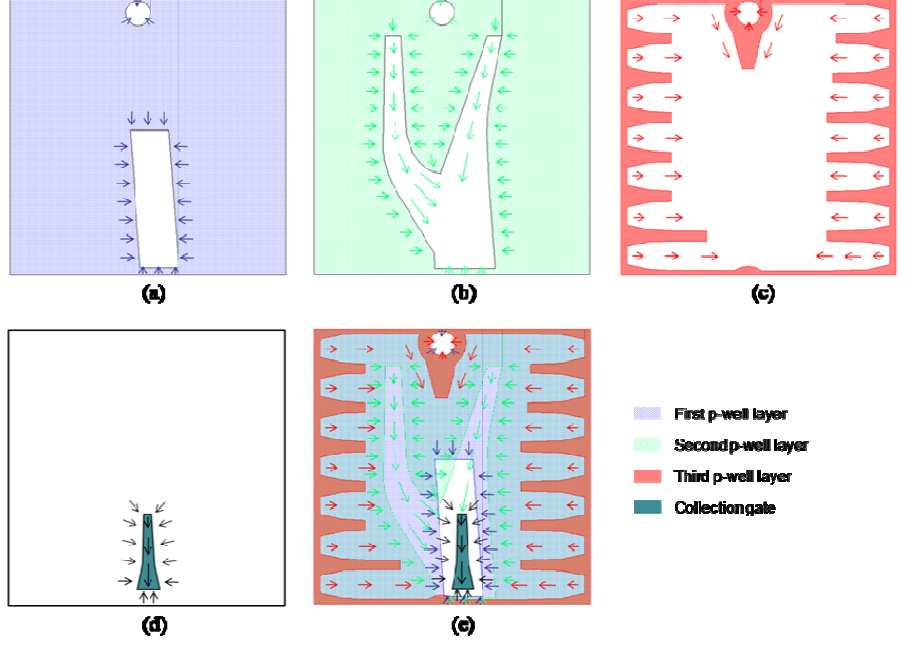
Figure 4. Designs of p-well and collection gate. (a), (b), (c): the first, second and third design masks of the p-well; (d) collection gate; and (e) superimposed p-well design. Arrows indicate transfer direction of photoelectrons.